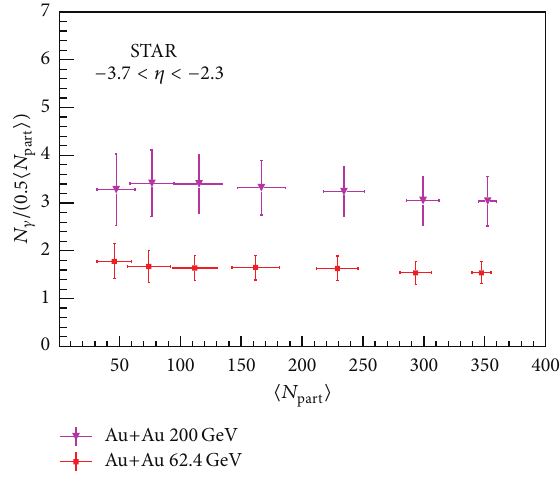
Figure 34: 𝑁 𝛾 normalized per participant pair as a function of 𝑁 for Au+Au for Au+Au beam